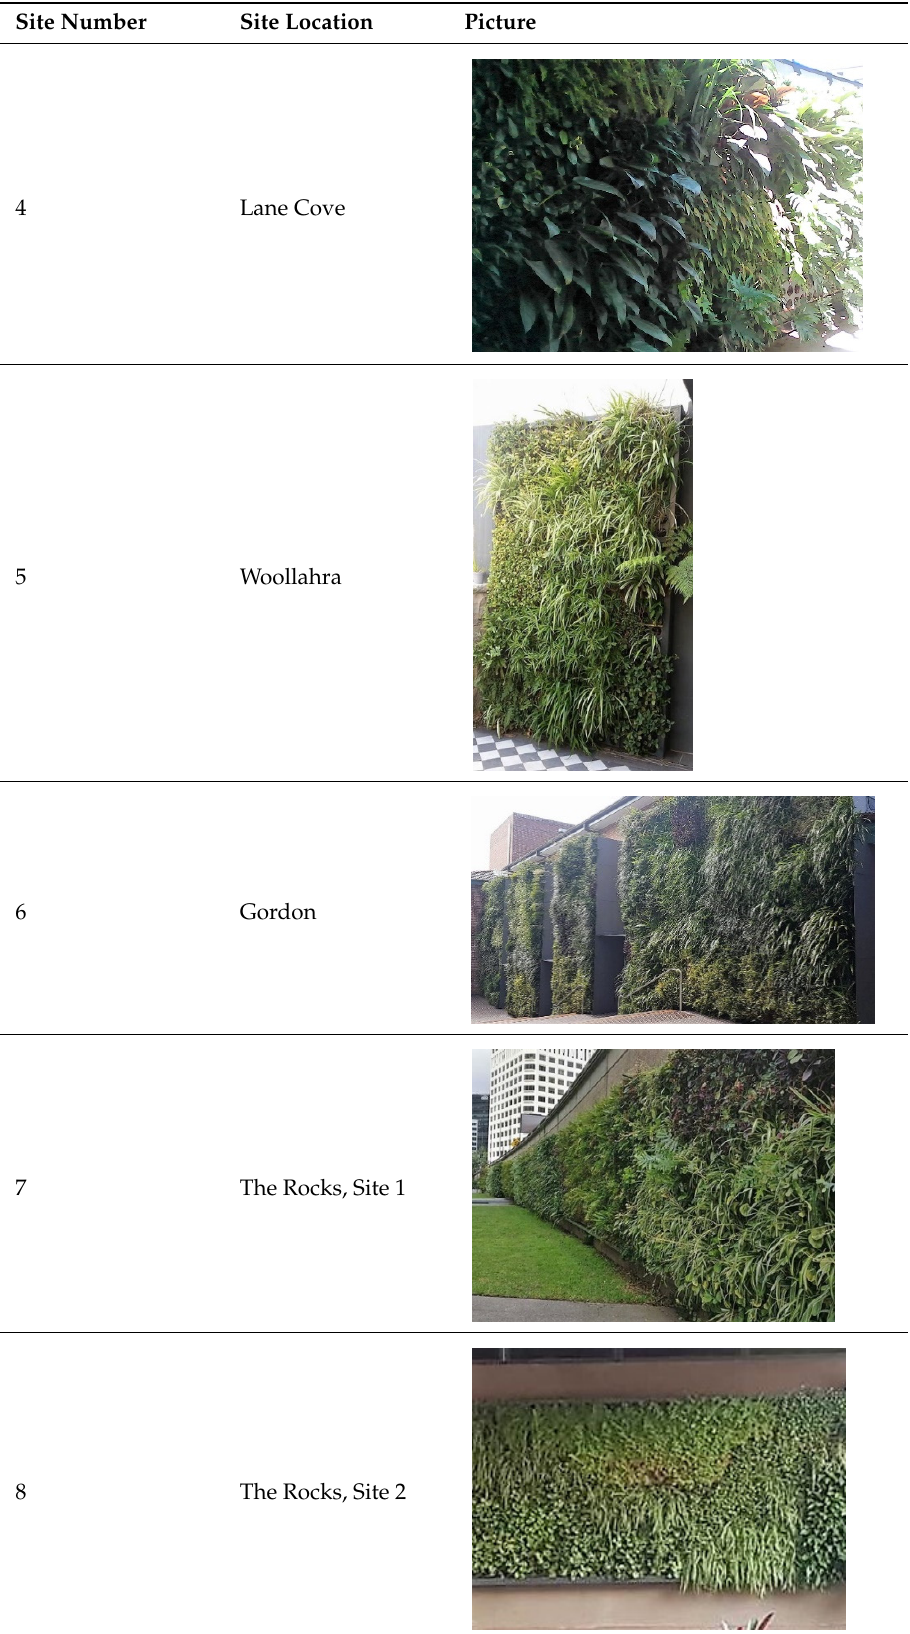
Table A1. Test sites with a visual